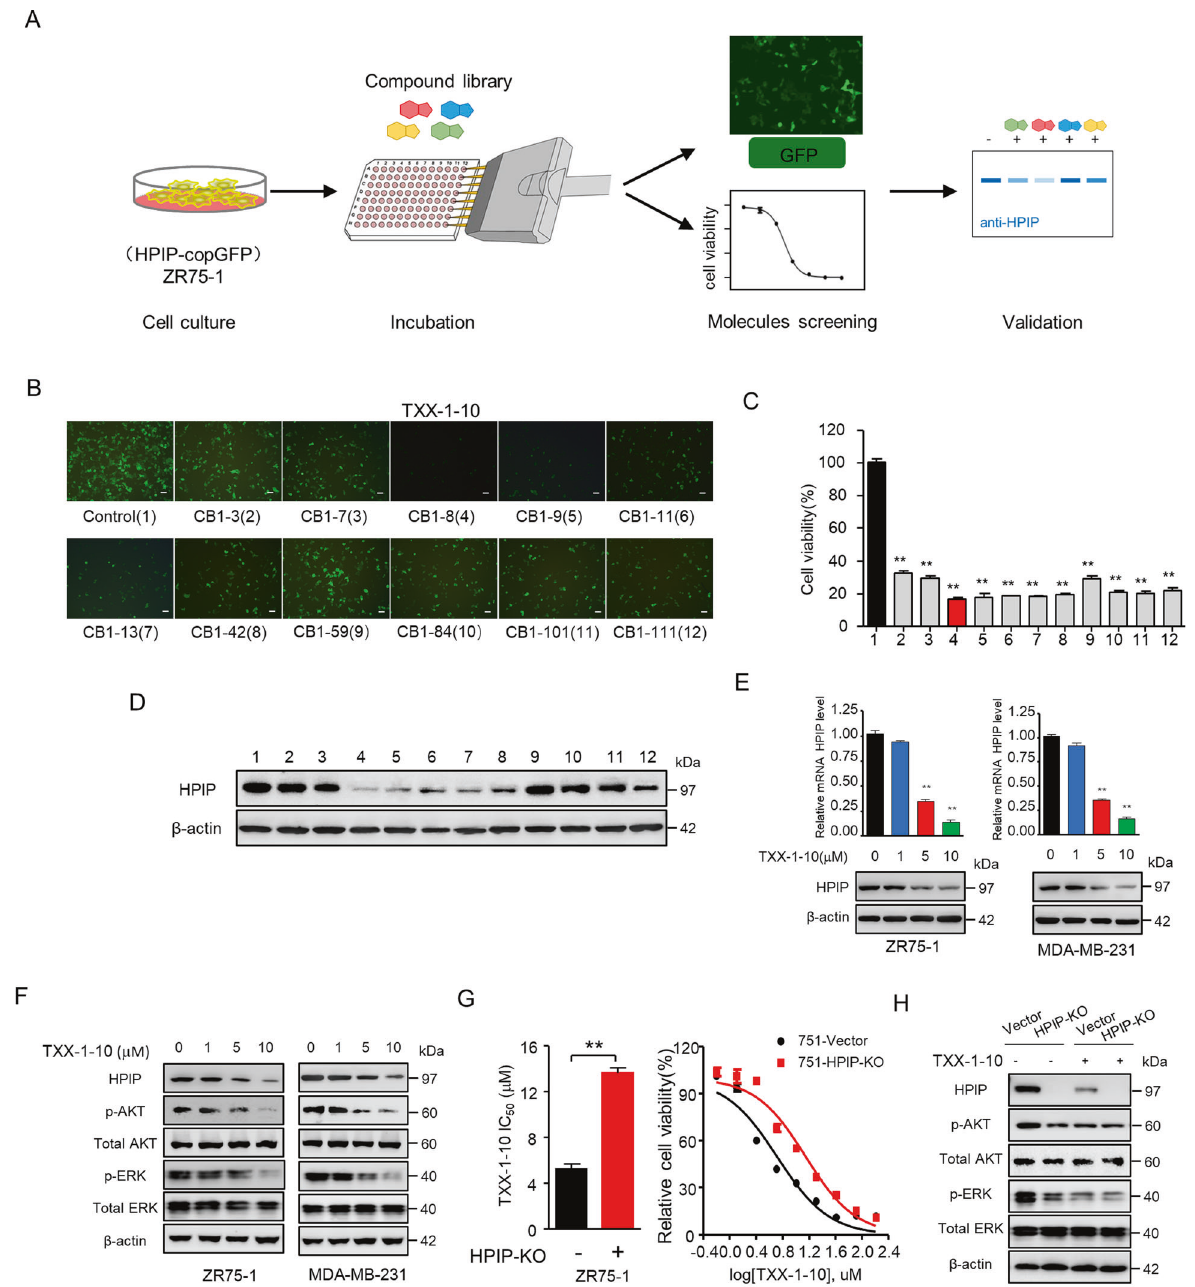
Fig. 1 Identi fi cation of the small chemical molecule TXX-1-10 inhibiting HPIP expression by cell-based screening. A Schematic representation of the protocol used to screen small molecules targeting HPIP. B Representative images of ZR75-1 cells stably expressing HPIP- copGFP treated with the indicated rimonabant derivatives for 48 h (10 μ M). Scale bars:100 μ m. C The antiproliferation function of the indicated rimonabant derivatives as in B of three independent experiments in ZR75-1 cells. D Western blot analysis of ZR75-1 cells treated with the indicated rimonabant derivatives as in B for 24 h. E qRT-PCR and Western blot analysis of relative HPIP expression in ZR75-1 and MDA-MB-231 cells treated with the indicated concentrations of TXX-1-10 for 24 h. F Western blot analysis of ZR75-1 and MDA-MB-231 cells with increasing concentrations of TXX-1-10 for 24 h. G Viability curves of wild type or HPIP knockout (KO) ZR75-1 cells treated with the indicated concentrations of TXX-1-10 for 48 h. TXX-1-10 IC 50 was assessed after 48 h. H Western blot analysis of ZR75-1 with TXX-1-10 (10 μ M)